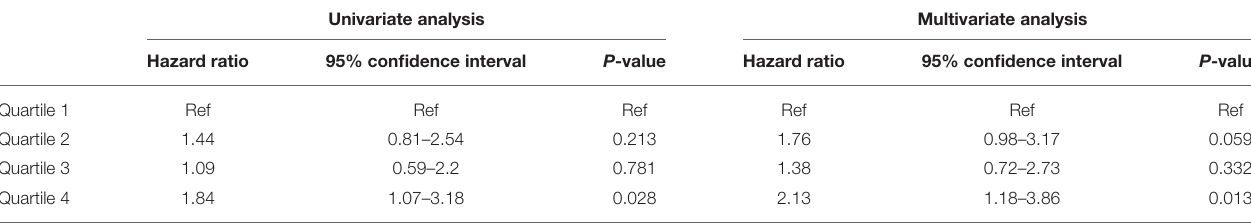
TABLE 3 | Association between sMg quartiles and death censored MACE by univariate and multivariate analysis.